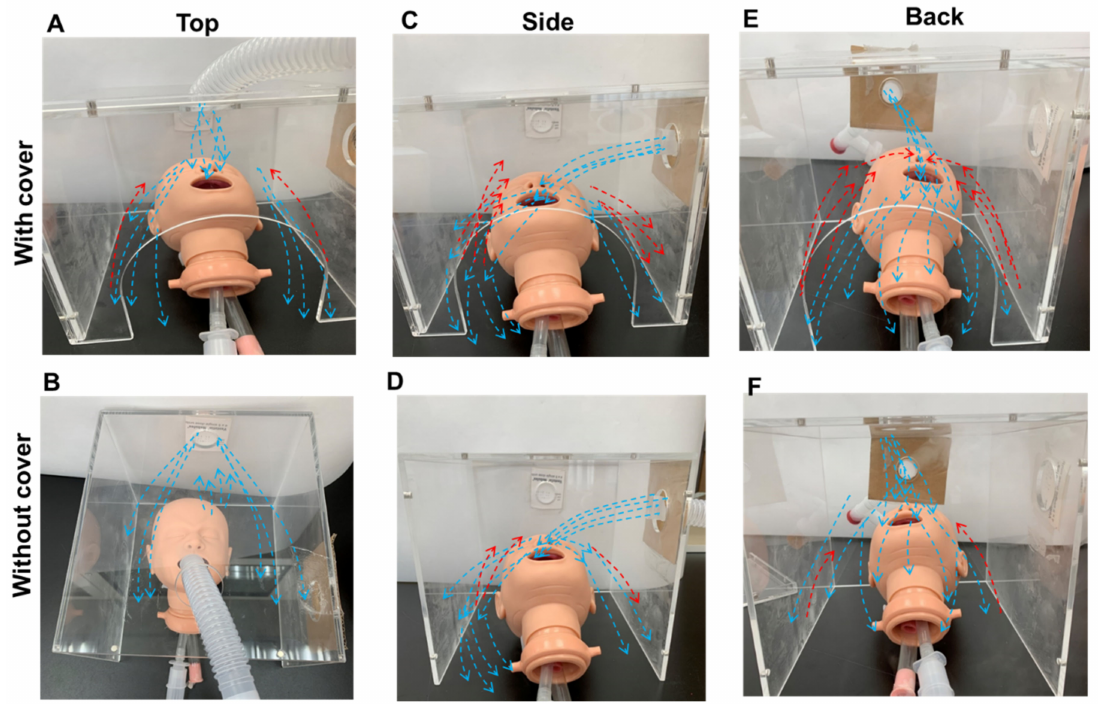
Figure 6. Aerosol delivery using a hood with a nebuliser placed at three positions: the side ( A , B ), back ( C , D ), and top ( E , F ), with ( A , C , E ) or without ( B , D , F ) a cover. The observed aerosol clouds are marked as blue lines for incoming aerosol clouds and red lines for bounced aerosol